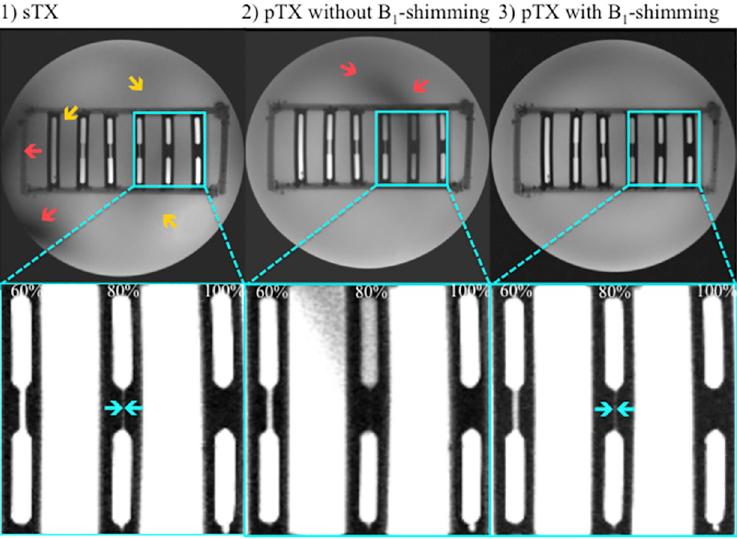
Fig 4. Imaging of stenosis phantoms (Gd-DOTA concentration 5.1 mM). First row: stenosis grade from left to right 0%, 20%, 40%, 60%, 80%, 100%. Second row: Magnified views of stenosis phantoms (60%, 80%, and 100%). To better visualize the stenosis area against the background, strongly windowed images were chosen for illustration. (1) Image acquired with a single transmit (sTX) coil shows strong shading artifacts only occurring at the edge of the lower-left quadrant (red arrow) and, thus, not affecting stenosis quantification. Minor field inhomogeneities in the center partly involve stenosis phantoms 0%, 60%, and 80% (yellow arrows). (2) Image from a parallel transmission (pTX) coil without B 1 -shimming depicts strong shading artifacts in the upper-right quadrant overlaying the 80% stenosis phantom (red arrow). In this case, reasonable stenosis quantification is not possible. (3) Images acquired with a pTX coil using automated B 1 -shimming provide superior image homogeneity and do not show relevant shading artifacts. High-grade stenoses (60% and 80%, cyan arrows) were graded significantly (p < 0.01) more precise compared to the conventional coil. No significant differences in stenosis grade between pTX and sTX coils were shown for 0%, 20%, and